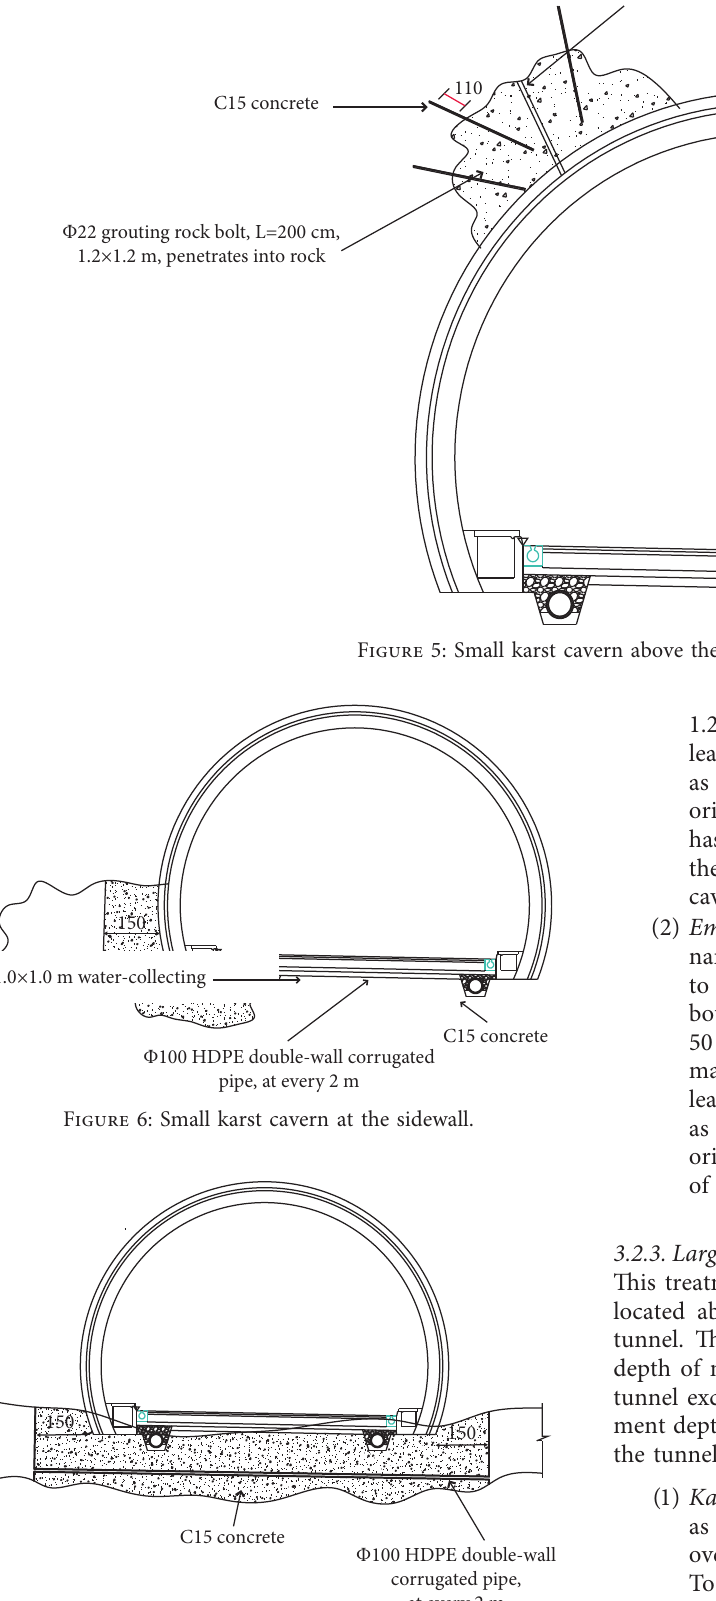
Figure 7: Small karst cavern at